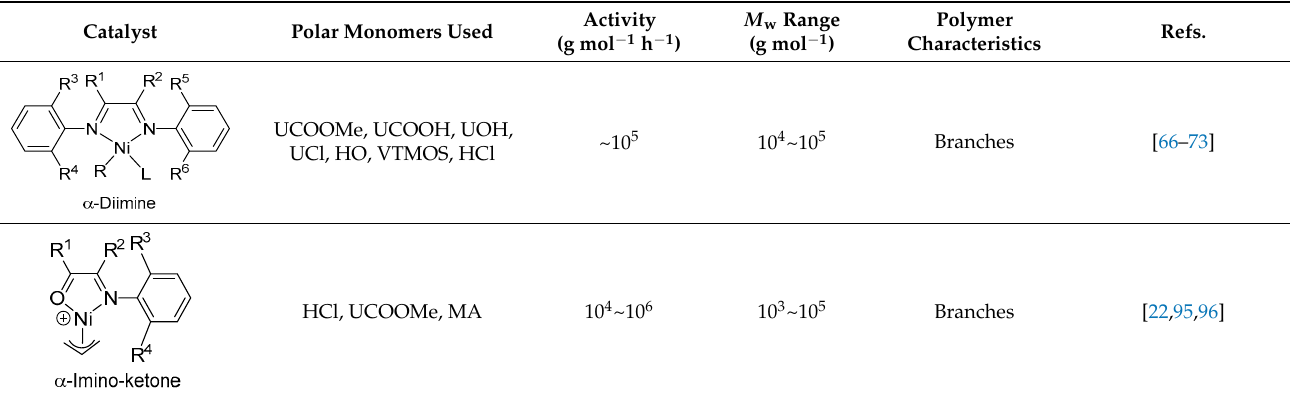
Table 1. Representative data for the copolymerization of ethylene and polar monomers with various types of catalysts.